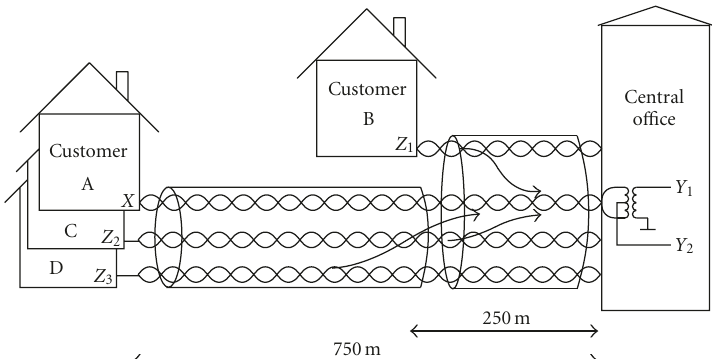
Figure 7: Near-far scenario: the upstream transmission of customer A is disturbed by strong FEXT from customer B, who is located closely to the central o ffi ce, and by weaker FEXT from customers C and D. All FEXT sources transmit with the same PSD of − 60 dBm/Hz as the far-end transmitter of customer A. The background-noise level on both DM port and CM port is − 140 dBm/Hz.